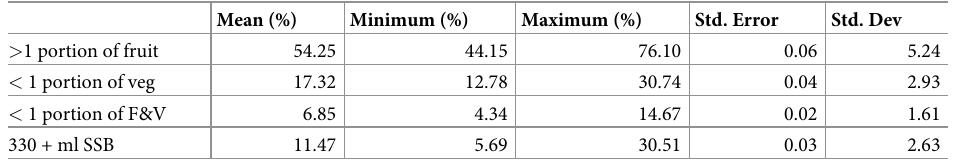
Table 2. Mean prevalence of consumption for each diet variable by